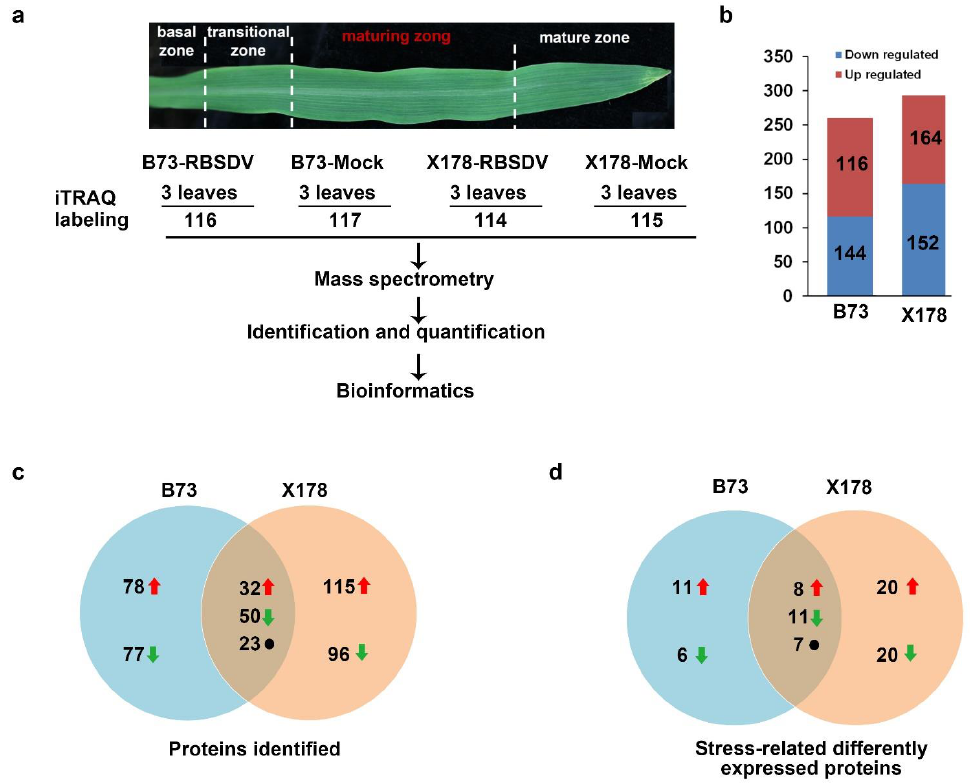
Figure 3. Flowchart for iTRAQ analyses and summary of differentially expressed proteins (DEPs) responsive to RBSDV infection in maturing zone of leaves on B73 and X178 plants. ( a ) Maturing zone of leaves in maize seedlings according to a previous report [23] was collected for iTRAQ. ( b ) Total number of up- and down-regulated proteins in leaves of RBSDV-infected B73 and X178, respectively. ( c ) Venn diagram representing the number of specific and common DEPs in RBSDV-infected B73 and X178. ( d ) Venn diagram representing the number of stress-related specific and common DEPs identified in RBSDV-infected B73 and X178. Red arrows represent up-regulated DEPs. Green arrows represent down-regulated DEPs. Black dots represent DEPs showing opposite expression trends in B73 and X178.